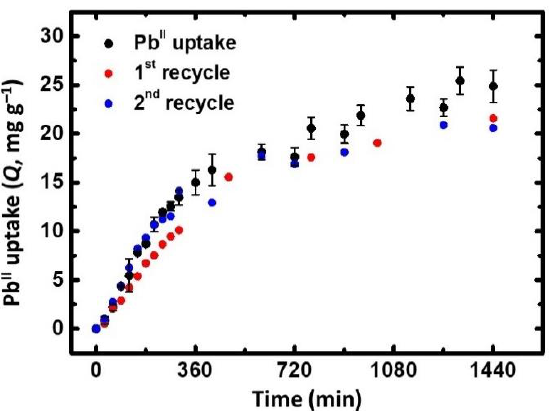
Figure 3. Black dots: Pb II uptake from ultrapure water solutions by X-Ca-alginate aerogel beads versus time. Red dots: 1st recycle. Blue dots: 2nd recycle. Initial Pb II concentrations: 40 mg/L −1 .